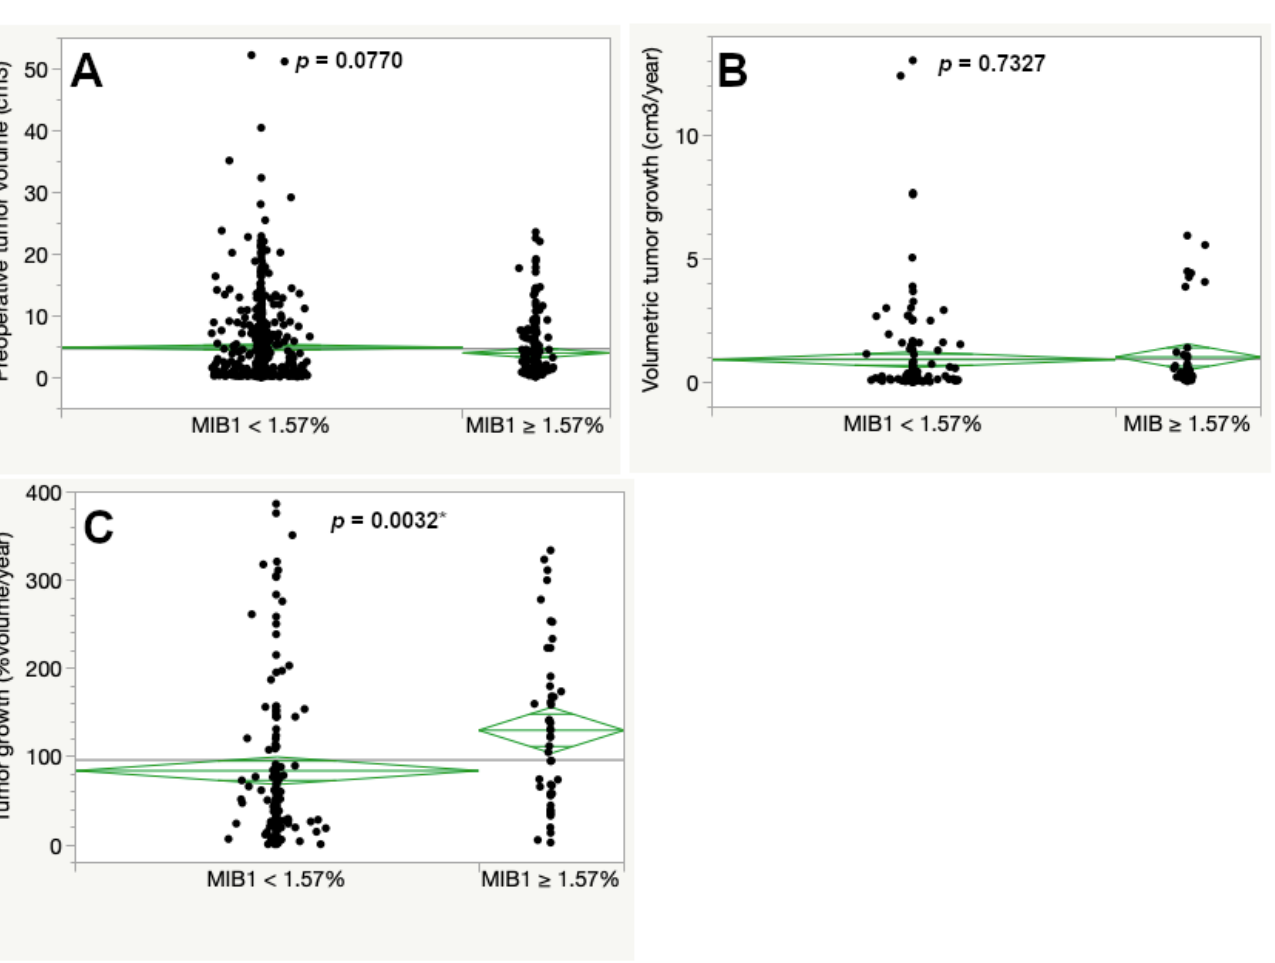
Figure 2. Preoperative tumor volume ( A ), volumetric tumor growth ( B ) and percentual volumetric tumor growth ( C ) in regard to the MIB1 expression in the tumor tissue. The cut-off at 1.57% was set according to a CART analysis regarding percentual volumetric growth (ANOVA; an asterisk (*) marks statistically significant results).